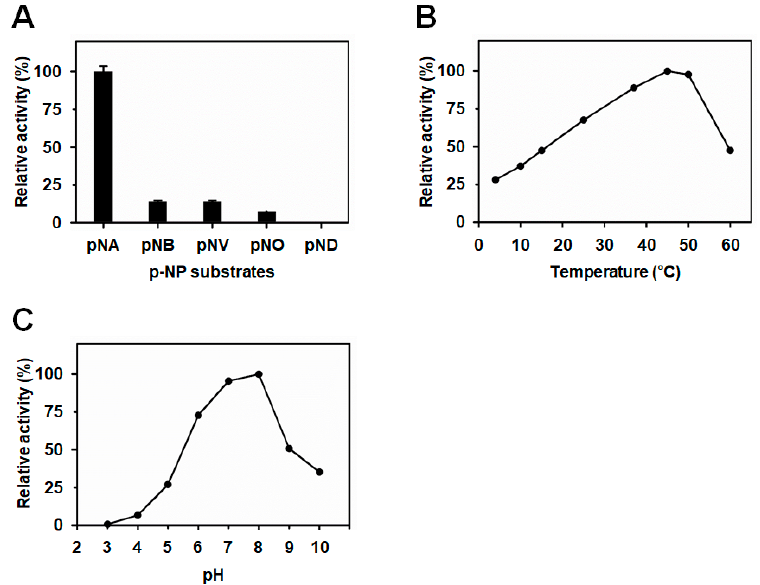
Figure 2. Biochemical characterization of Burkholderiaceae sp. S-formylglutathione hydrolase ( Bu SFGH). ( A ) Substrate specificity was investigated using p-nitrophenyl esters with different acyl- chain lengths. ( B ) Enzyme activity change of Bu SFGH was monitored at different temperatures (4–60 ◦ C). ( C ) Enzyme activity change of Bu SFGH was monitored at different pHs (pH 3.0–pH 10.0). Table 2. Structural homolog search results for Bu SFGH, from a DALI search (DALI-Lite